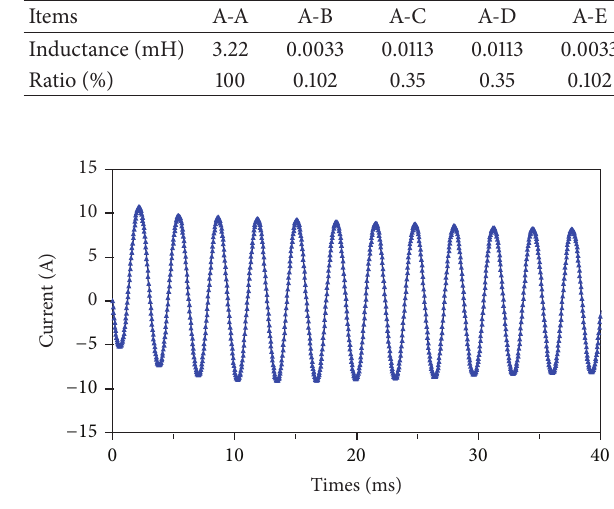
Figure 13: Short-circuit